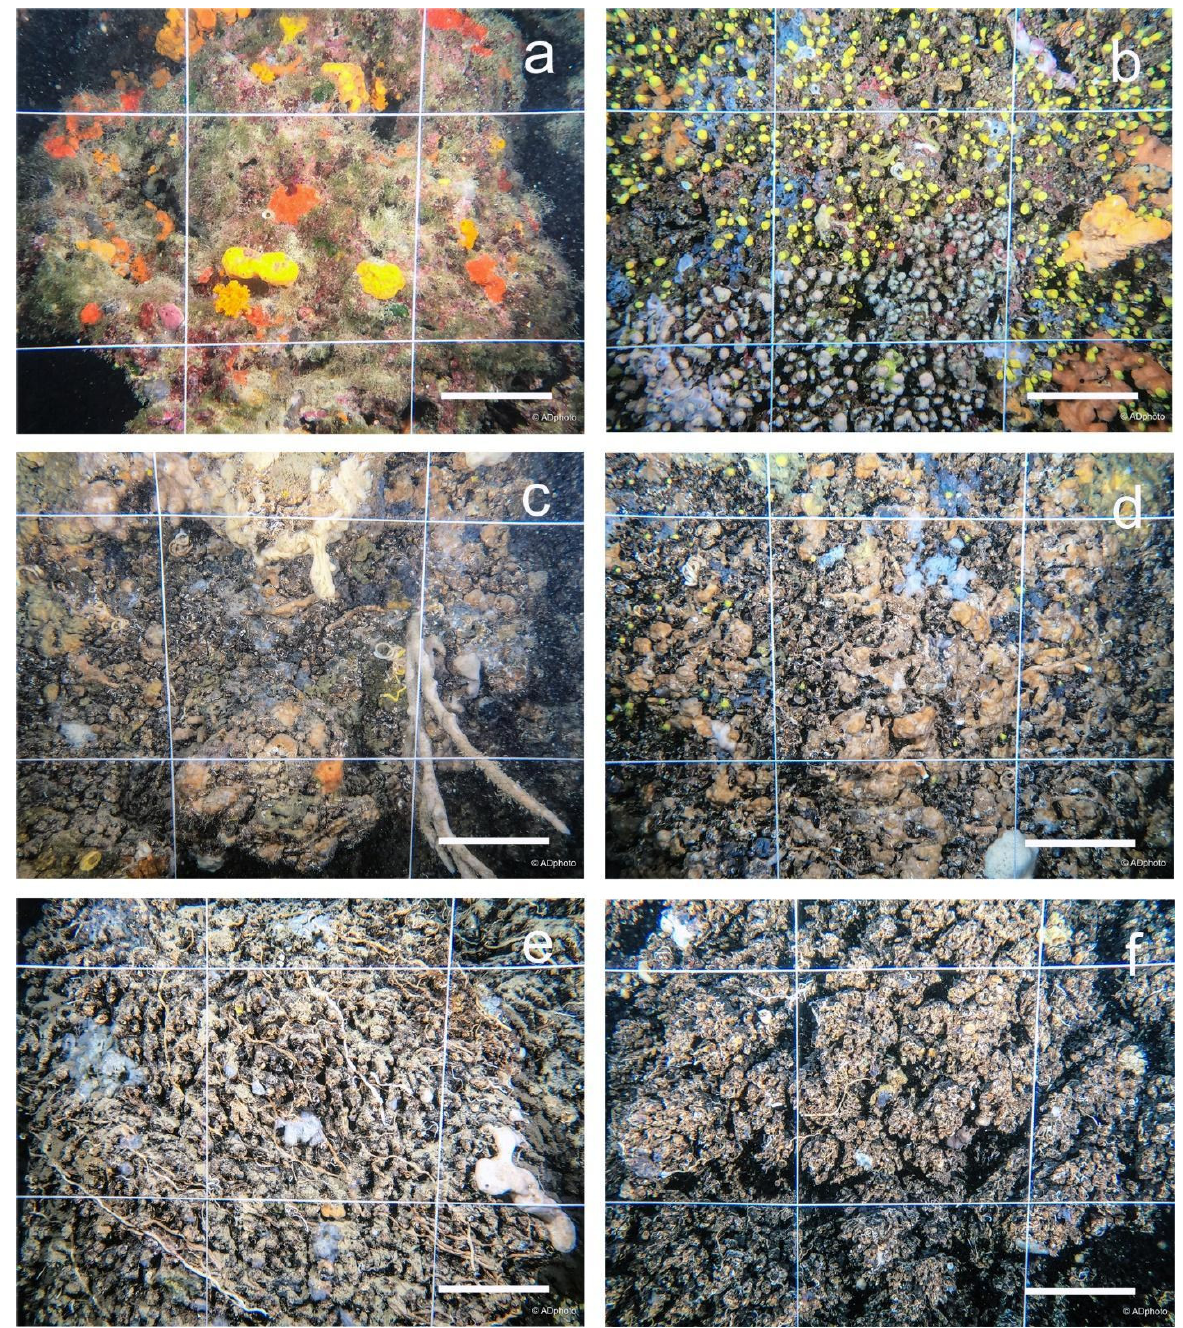
Figure 6. Details of the wall and ceiling of the three sectors of the Elle cave: ( a ) Entrance wall covered by algae mixed with coralligenous sponge species, i.e., Spirastrella cuntatrix , Agelas oroides , Petrosia ficiformis, and Achantella acuta ; ( b ) entrance ceiling covered by scleractinians Madracis pharensis , Leptopsammia pruvoti, and Hoplangia durotrix ; ( c ) wall of the intermediate sector with specimen of cf. Pseudocorticium jarrei (on the top) associated with other encrusting and erect Demospongiae and coiled doughnuts of tubes of Protula tubularia ; ( d ) ceiling of the intermediate sector with sparse specimens of L. pruvoti , numerous tubes of small serpulids, the coiled doughnuts of P. tubularia, and the Calcarea sponge Petrobiona massiliana (at the bottom of the image); ( e ) wall of the bottom sector with few encrusting sponges and numerous long serpulid tubes aligned parallel to the water flow; ( f ) ceiling of the bottom sector with numerous specimens of brachiopods Novocrania anomala and not identified Articulata.